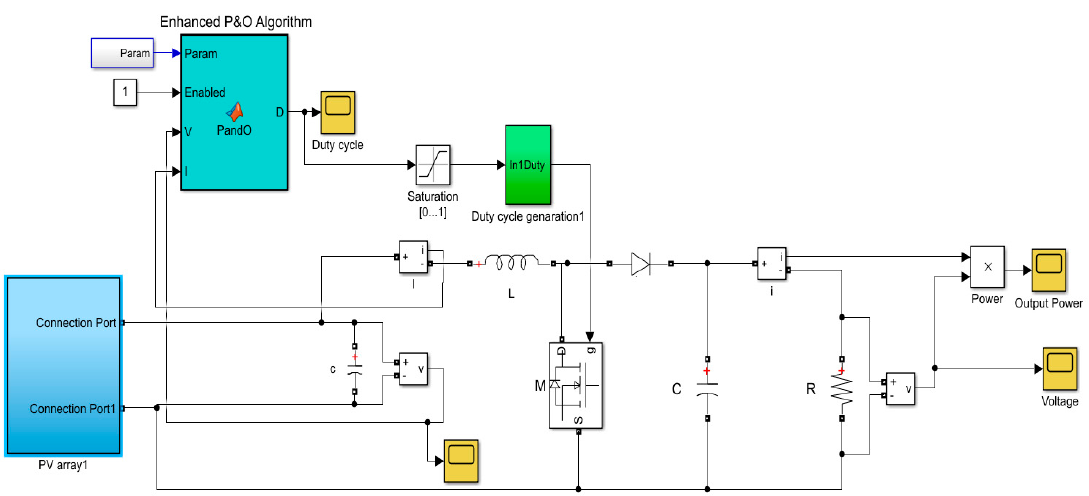
Figure 6. Simulink model of the MPPT controller using a boost converter.